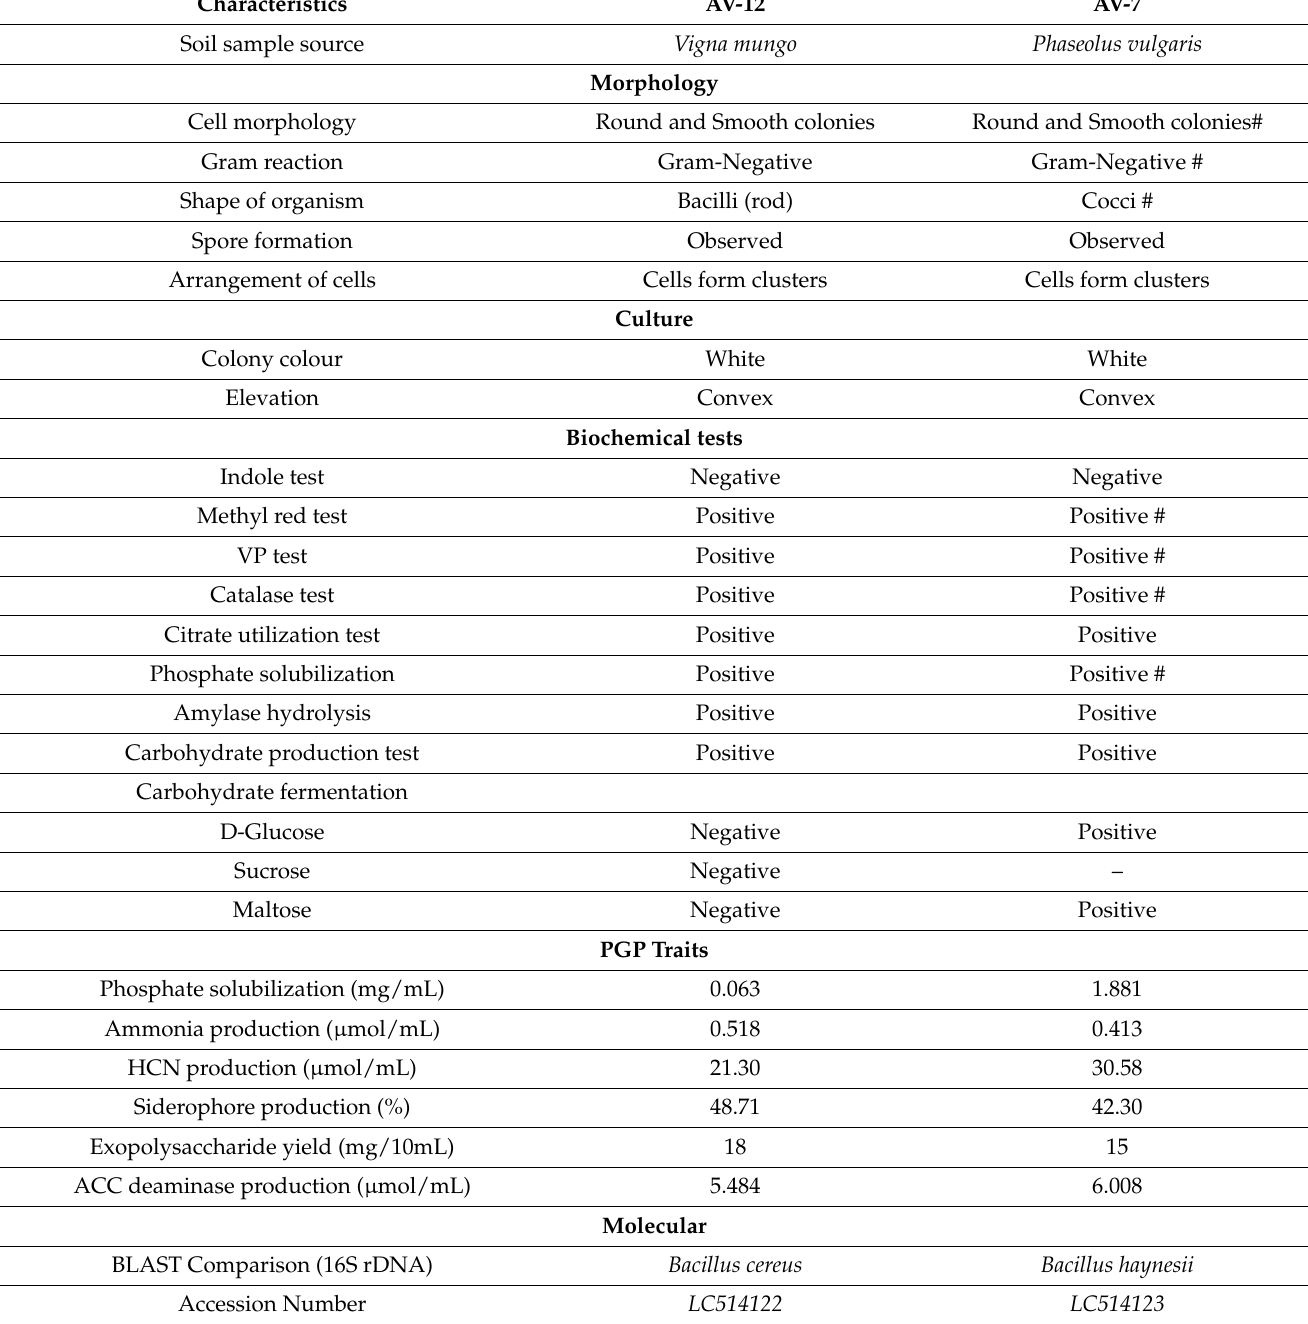
Table 1. Source of rhizosphere soil and morphological, biochemical, and molecular characteristics of bacterial